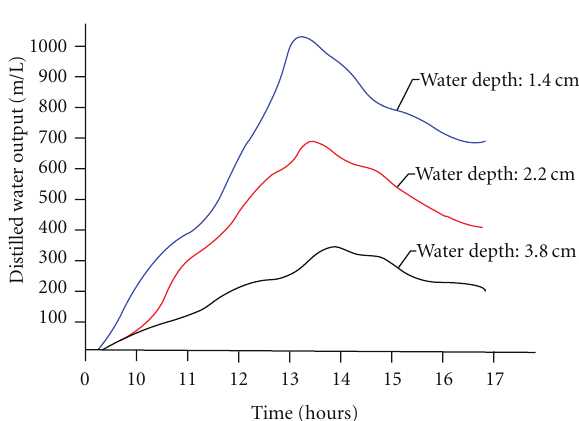
Figure 7: E ff ect of water depths (1.4cm, 2.2cm, and 3.8cm) on solar still